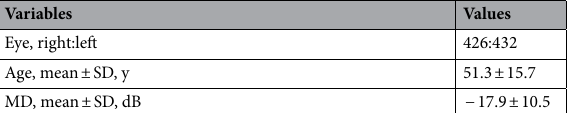
Table 1. Demographic data of the patients for the cluster developing. SD standard deviation, MD mean deviation.